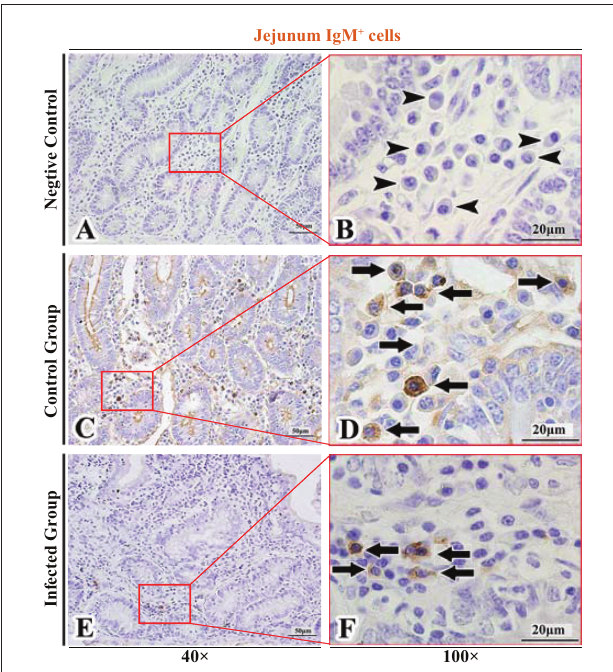
FIGURE 7 | Distribution of IgM + cells in sheep jejunum. (A,B) are negative controls; (C,D) are Control groups; (E,F) are Infected groups. Triangular arrows indicated plasma cells, arrows indicated IgM + cells, and the right image (Scale bar, 20 µ m) is a magnification from the part of the left image (Scale bar, 50 µ m). field were counted, and the respective densities were calculated (Image-Pro Plus 6.0) (49, 50). SPSS 23.0 (SPSS Inc., Chicago, USA) was used for statistics. One-way analysis of variance with Duncan’s new multiple range test was used to analyze the density differences of each positive cell among various sites in the same group; independent T -test was used to analyze the differences between the Infected group and Normal group for the same site. P < 0.05 means significant difference, P > 0.05 means no significant difference.